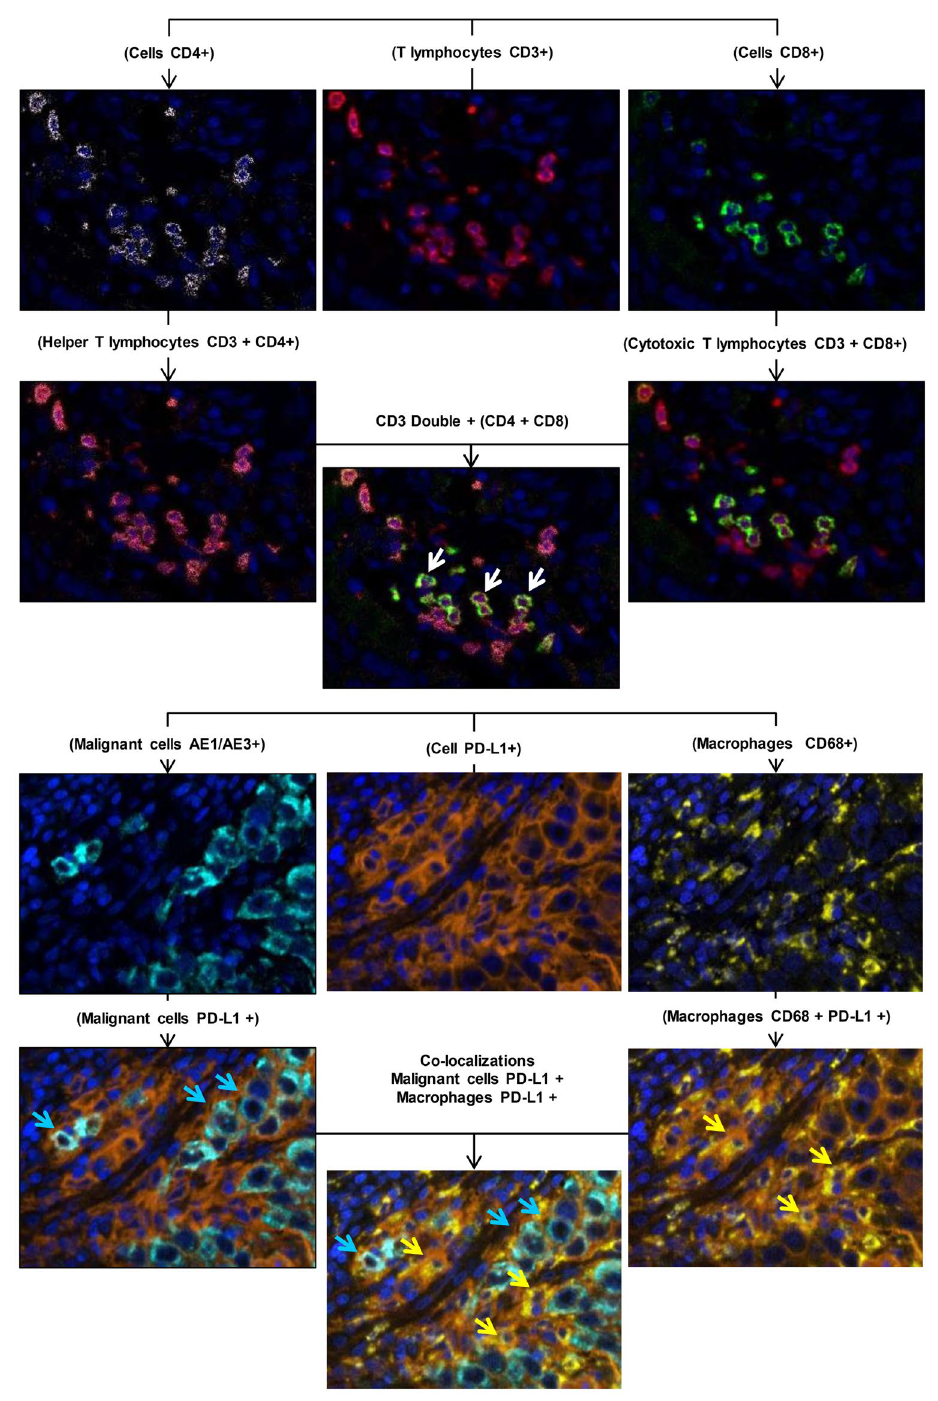
Figure 4. Microphotographs of representative examples of co-localization of the cell markers observed in panel